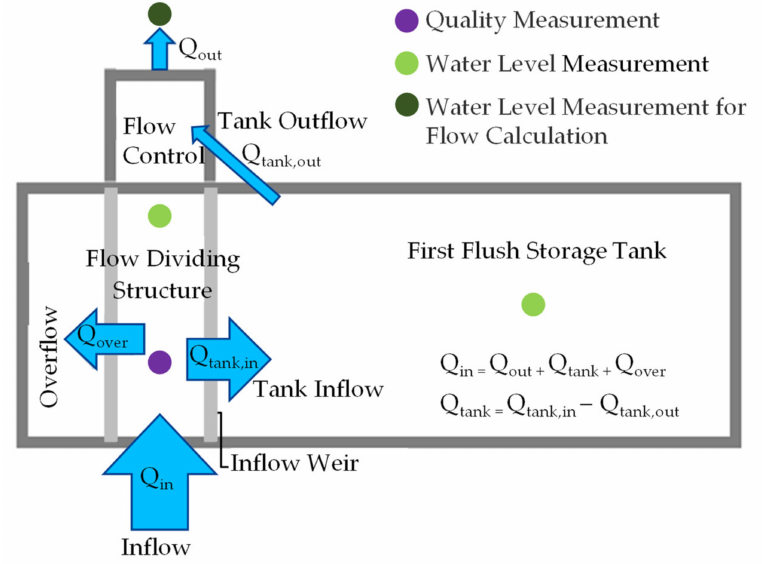
Figure 1. Schematic overview of first flush storage tanks with location of measurement devices [67] after